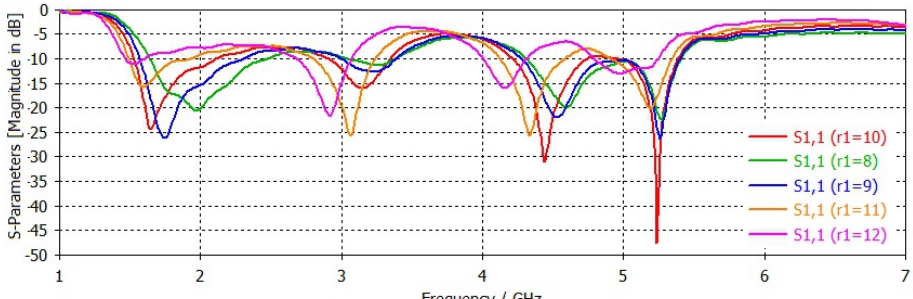
Figure 5. The simulated input reflection coefficient of the antenna for different values of r 1